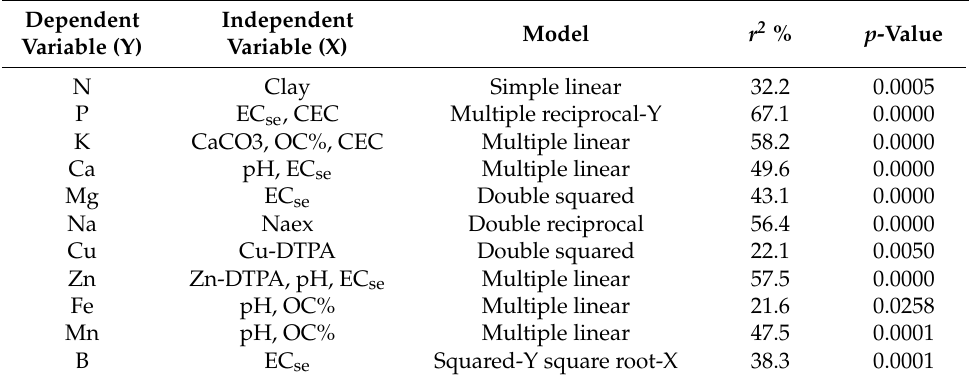
Table 5. Single and multiple regression models between the tulips’ above-ground biomass elements concentrations (Y) and the respective soil physicochemical properties (X). r 2 : coefficient of deter- mination; OC: organic carbon; CEC: cation exchange capacity; EC se : electrical conductivity of the saturation extract; and Naex: exchangeable amounts of Na extracted with the ammonium acetate method; n =